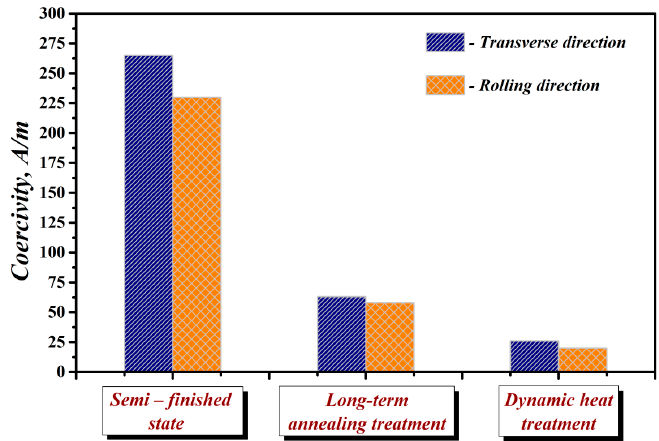
Figure 9. Dependence of the heat treated segments coercivity on the annealing conditions and radial direction.